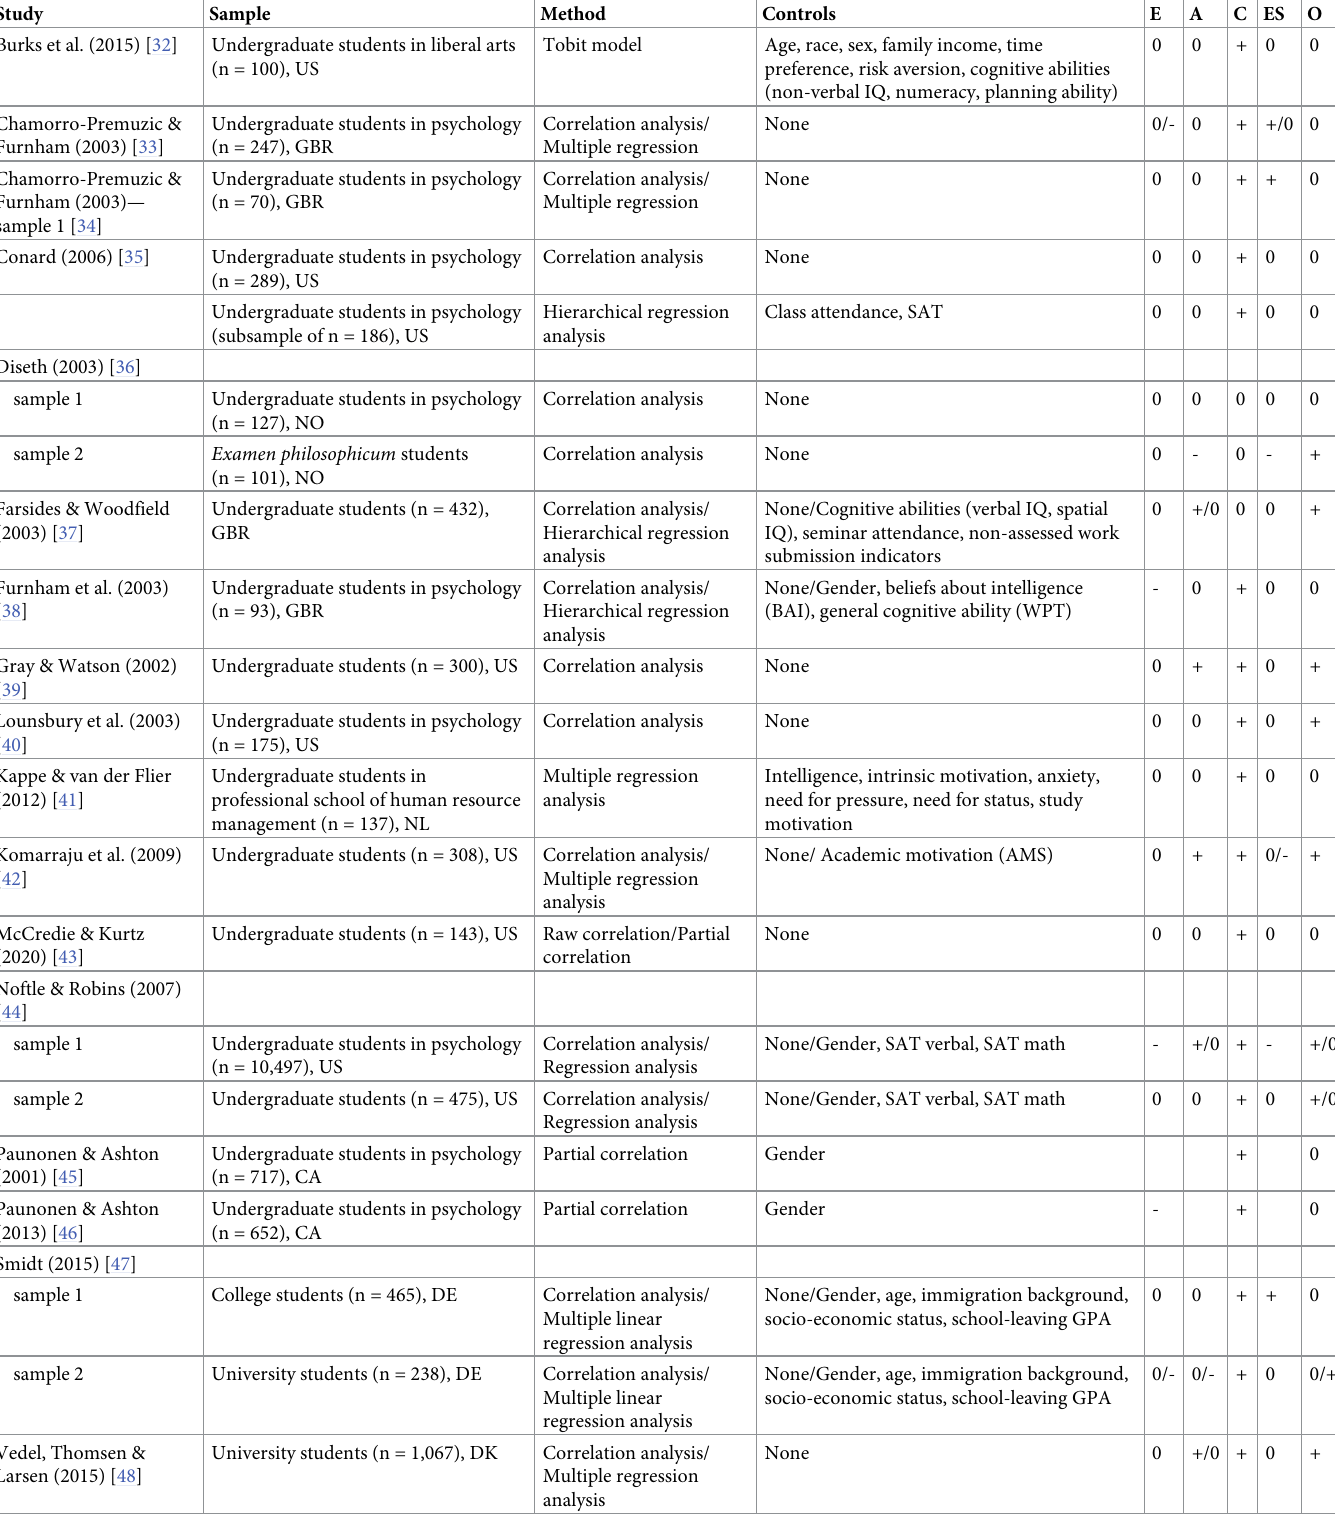
Table 1. Previous findings on the effects of the Big Five personality traits on post-secondary examination